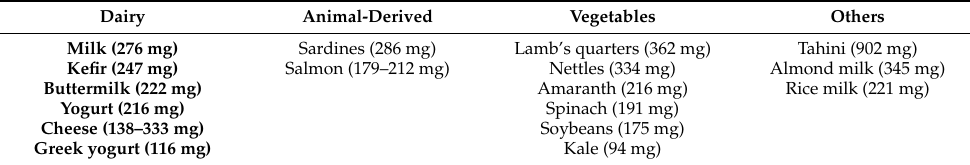
Table 2. Foods with high calcium content (calcium content in mg per 100 g serving). Dairy Animal-Derived Vegetables